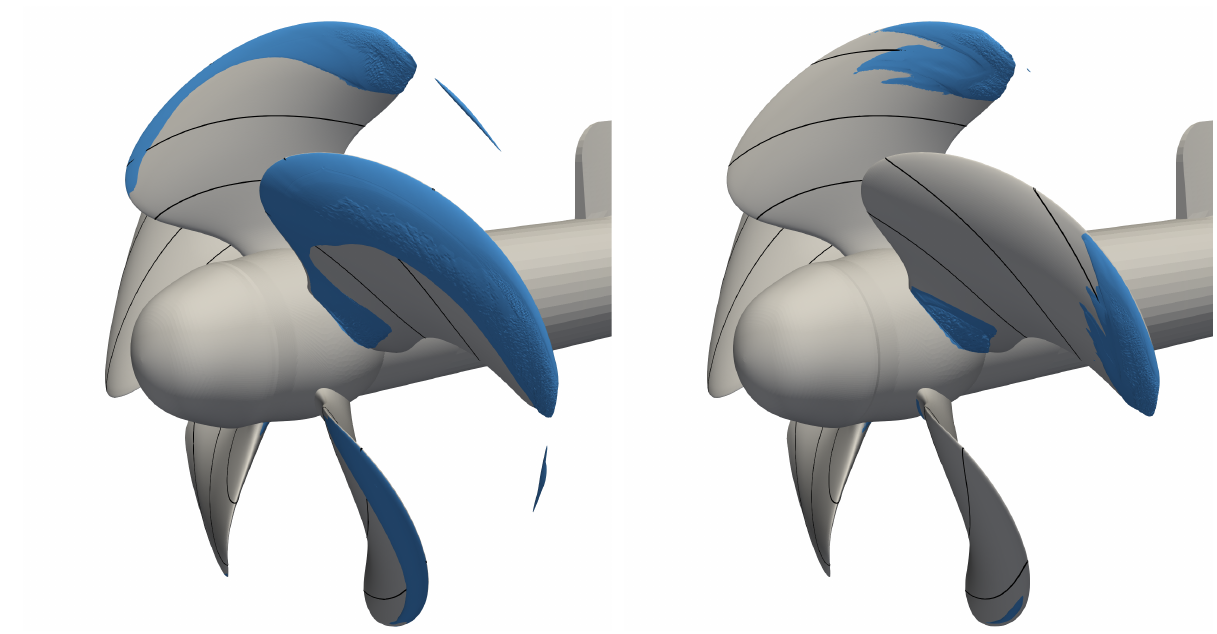
Figure 21. Predicted cavitation patterns α v = 0.5, J = 0.85, σ = 2.0. Left frame : unbridged k − ω SST + SS ; right frame : bridged